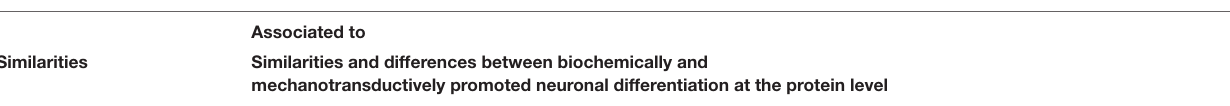
TABLE 1 | Similarities between biochemically and mechanotransductively promoted neuronal differentiation at the protein level by comparing the conditions ns-Zr15, NGF, and